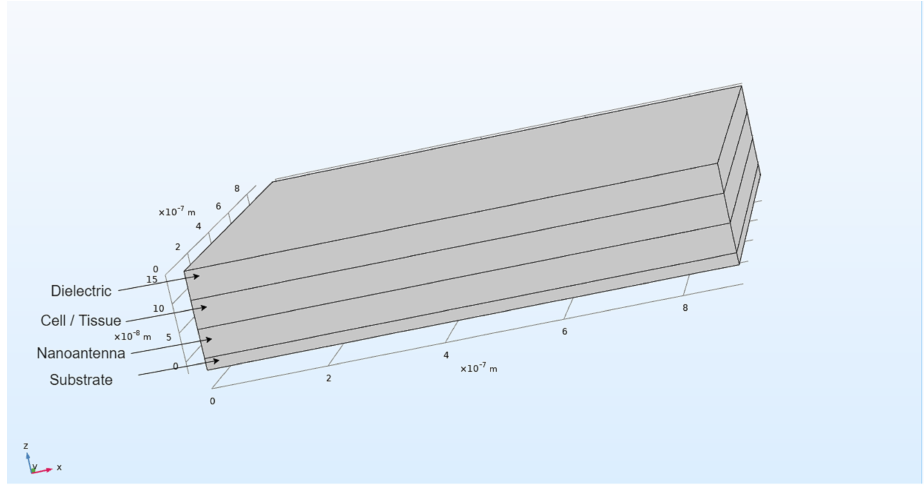
Figure 16. Topology of the simulated sensor